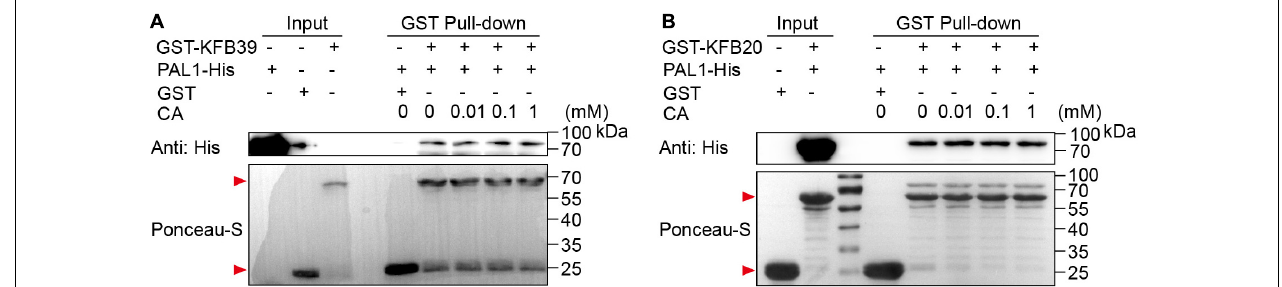
FIGURE 5 | Coniferyl alcohol has no effect on the interaction between KFBs and PAL1 in GST pull-down assays. Lack of effect of CA on the physical interaction of PAL1-His with GST-KFB39 (A) or GST-KFB20 (B) in vitro was verified by GST pull-down assays. PAL1-His and GST-KFB39 (A) or GST-KFB20 (B) were incubated in binding buffer containing different concentrations of CA, and GST resin was washed for five times and eluted. His-tagged protein was immunoblotted using anti-His antibody and GST-tagged protein was stained by Ponceau S. Red arrows indicate GST-tagged proteins.